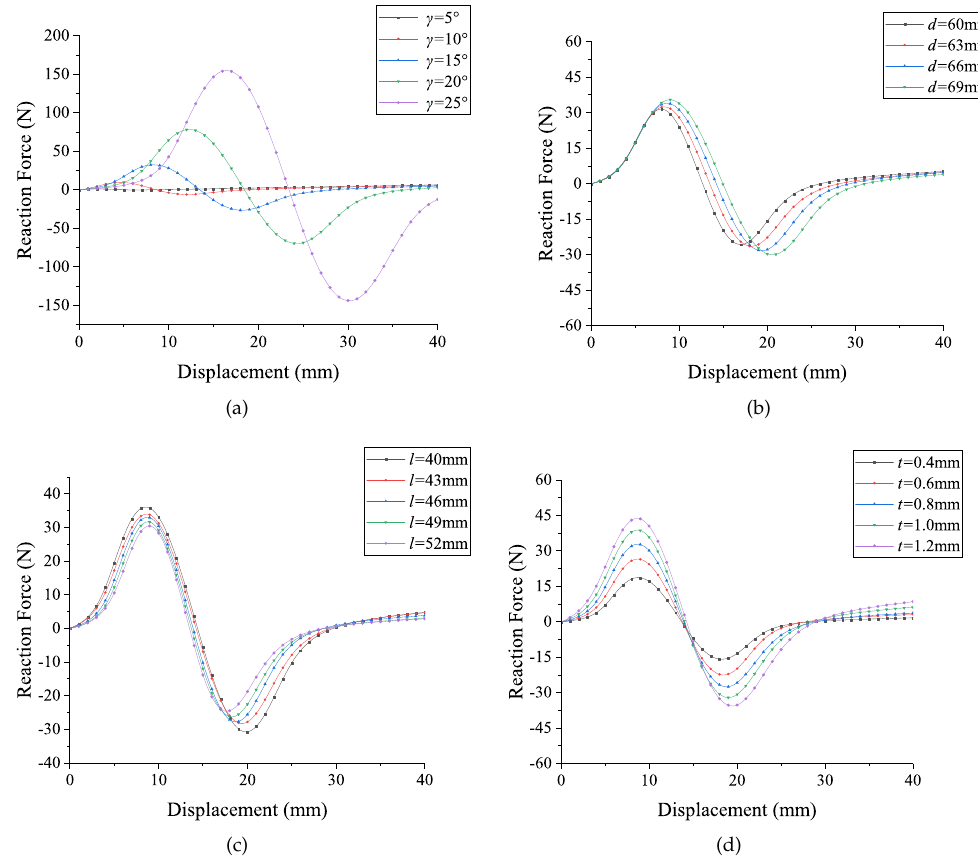
Figure 5. The bistable curves under different variables: ( a ) the angle γ as variable; ( b ) the distance between middle points d as variable; ( c ) the segment length l as variable; ( d ) the thickness of segments t as